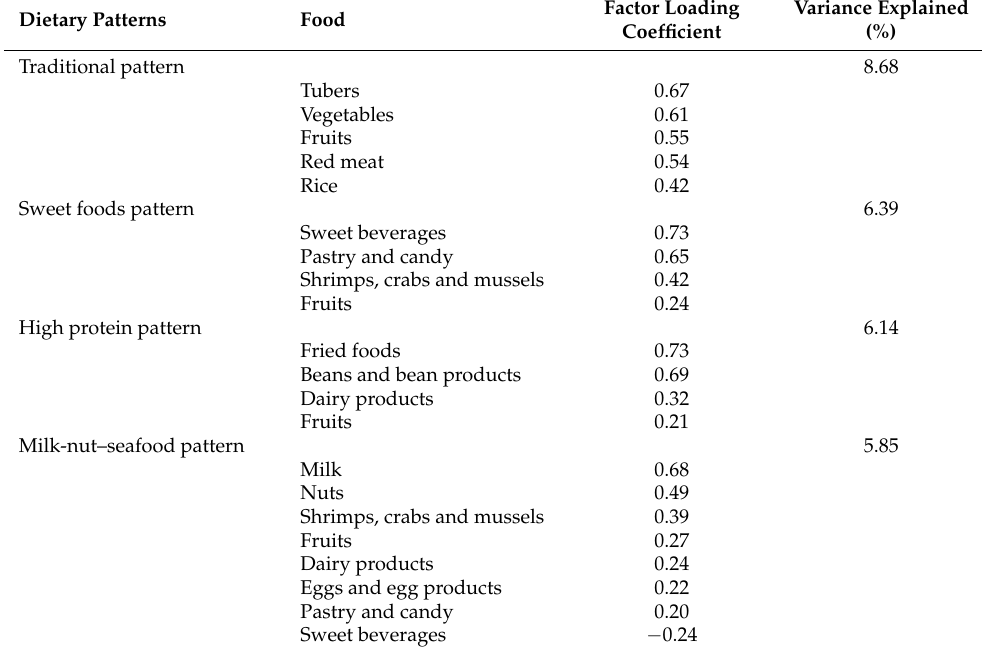
Table 2. Factor loadings of derived dietary patterns from 3-day food diaries ( n = 1026). Dietary Patterns